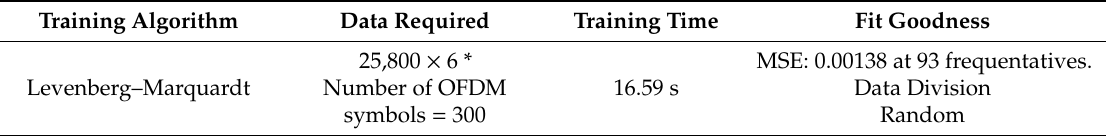
Table 3. Learning algorithm.